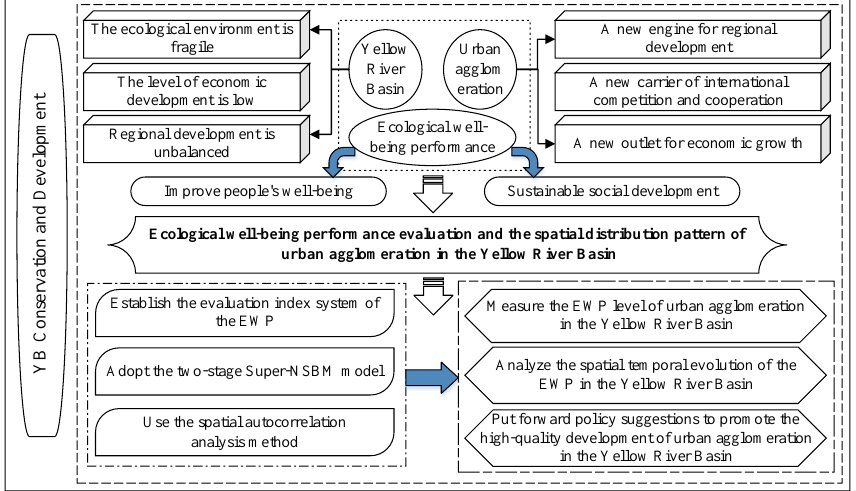
Figure 1. The schematic diagram of the overall research method of this study.